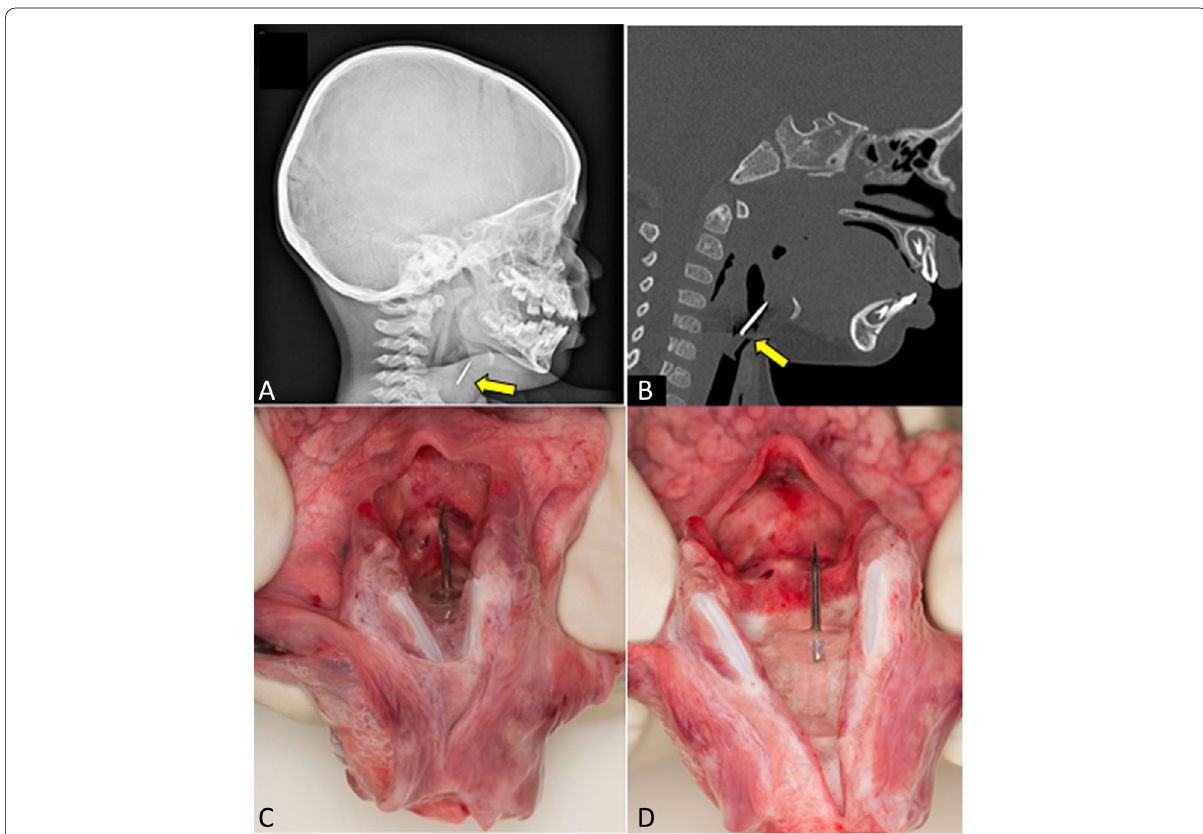
Fig. 1 Postmortem diagnosis of push pin aspiration in a child. A Postmortem lateral head x-ray demonstrating a hyperdense, linear, pointed foreign body in the region of the larynx (identified with yellow arrow). B Postmortem CT (sagittal skull and c-spine reformat) demonstrating the same foreign body in larynx (identified with yellow arrow). C and D Sequential autopsy dissection photographs of the larynx, demonstrating the aspirated push pin made of clear plastic occluding the airway at the level of the vocal